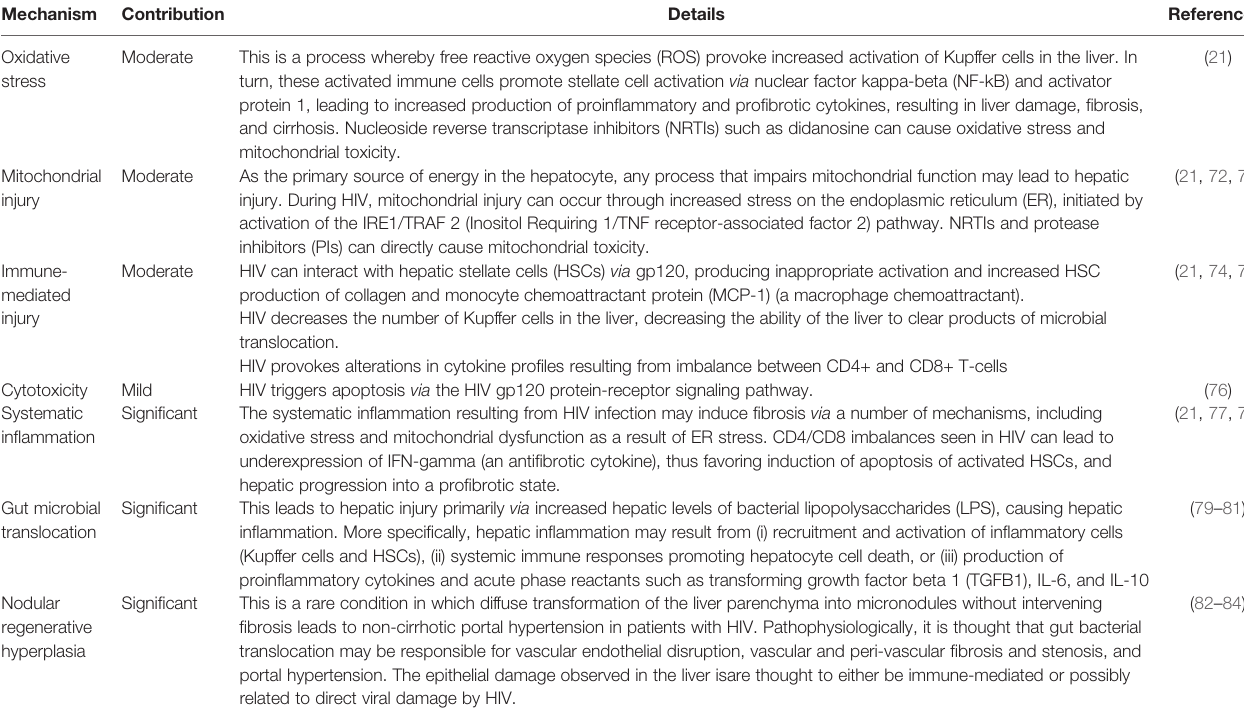
TABLE 1 | Summary of reported mechanisms responsible for liver injury in patients with